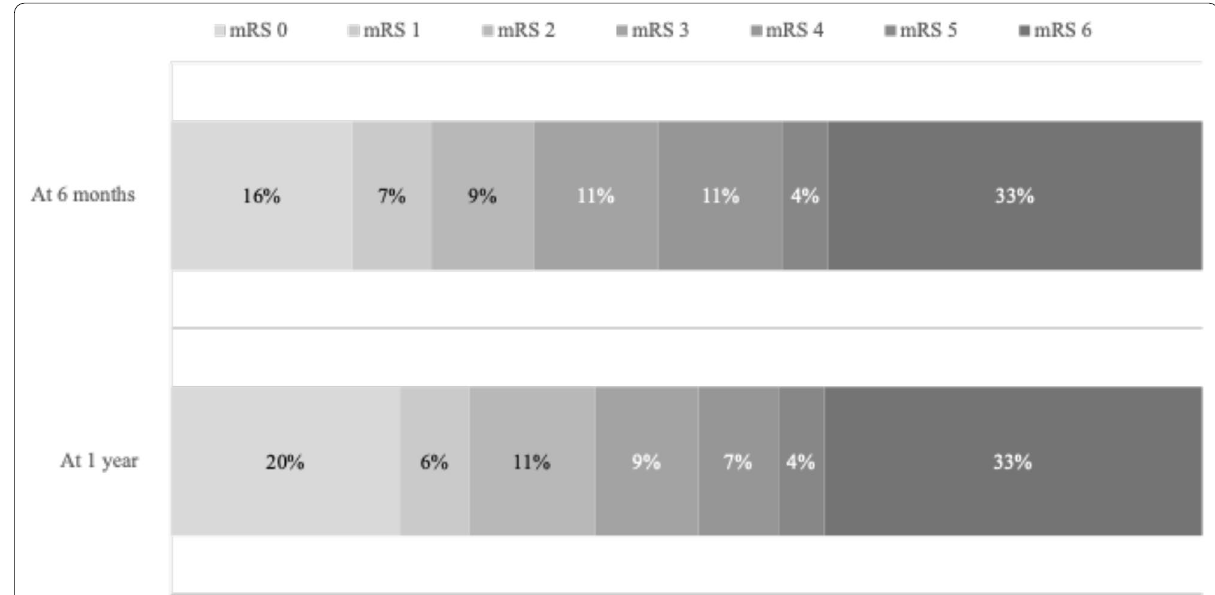
Fig. 2 Neurologic outcome assessed with the modified Rankin Scale 6 months and 1 year after ICU discharge. Missing data: 5 (9%) patients at 6 months and 5 (9%) patients at 1 year. ICU: intensive care unit; VZV: varicella‑zoster